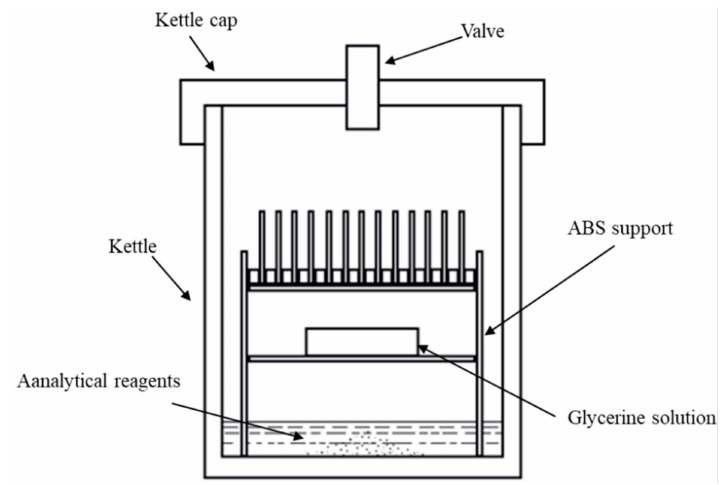
Figure 2. Schematic diagram of the simulated corrosion test